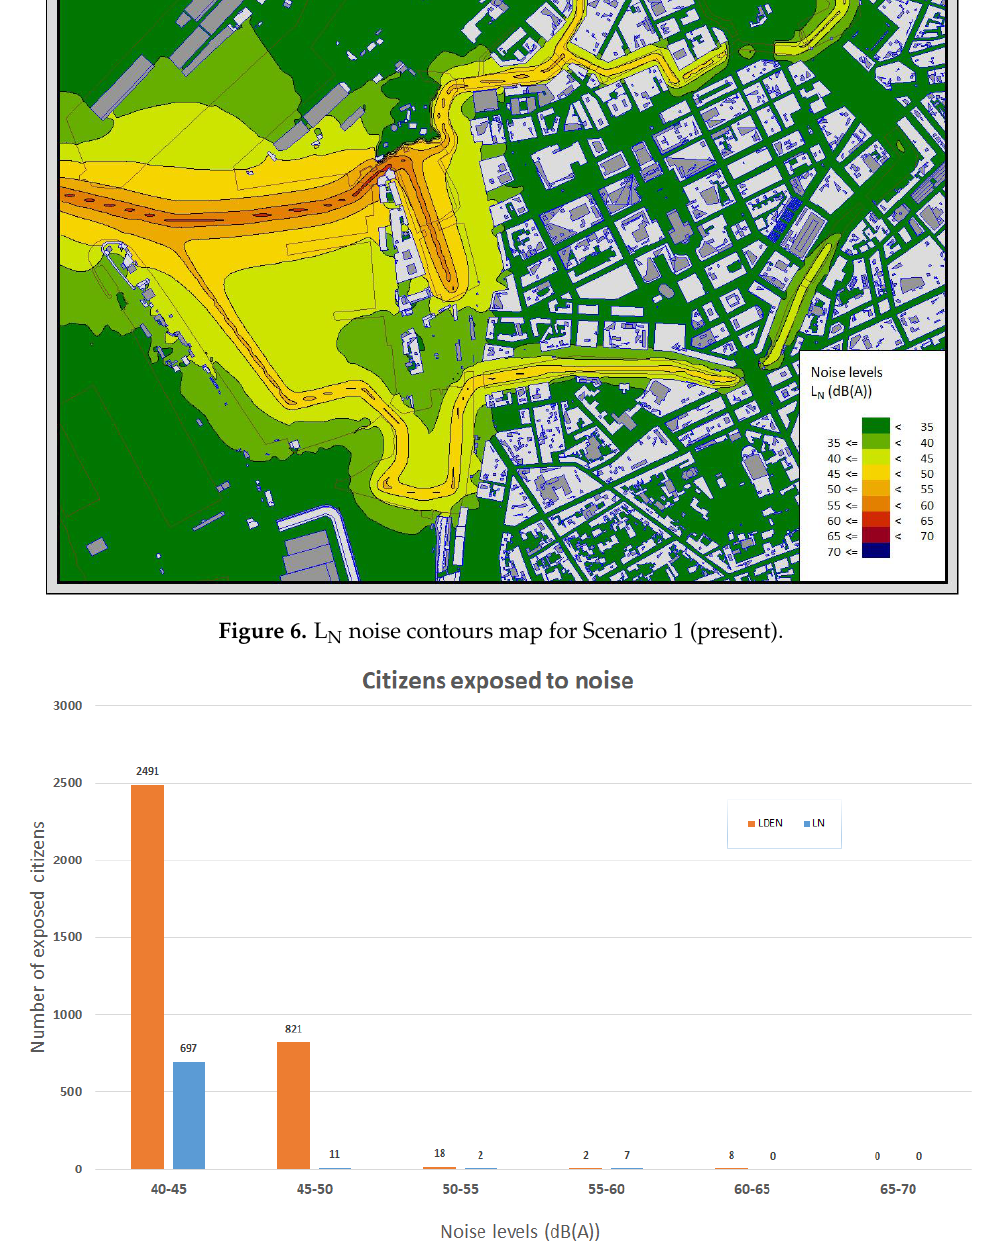
Figure 7. Number of citizens exposed to noise levels above 40 dB(A) of L DEN or L N in Scenario 1.